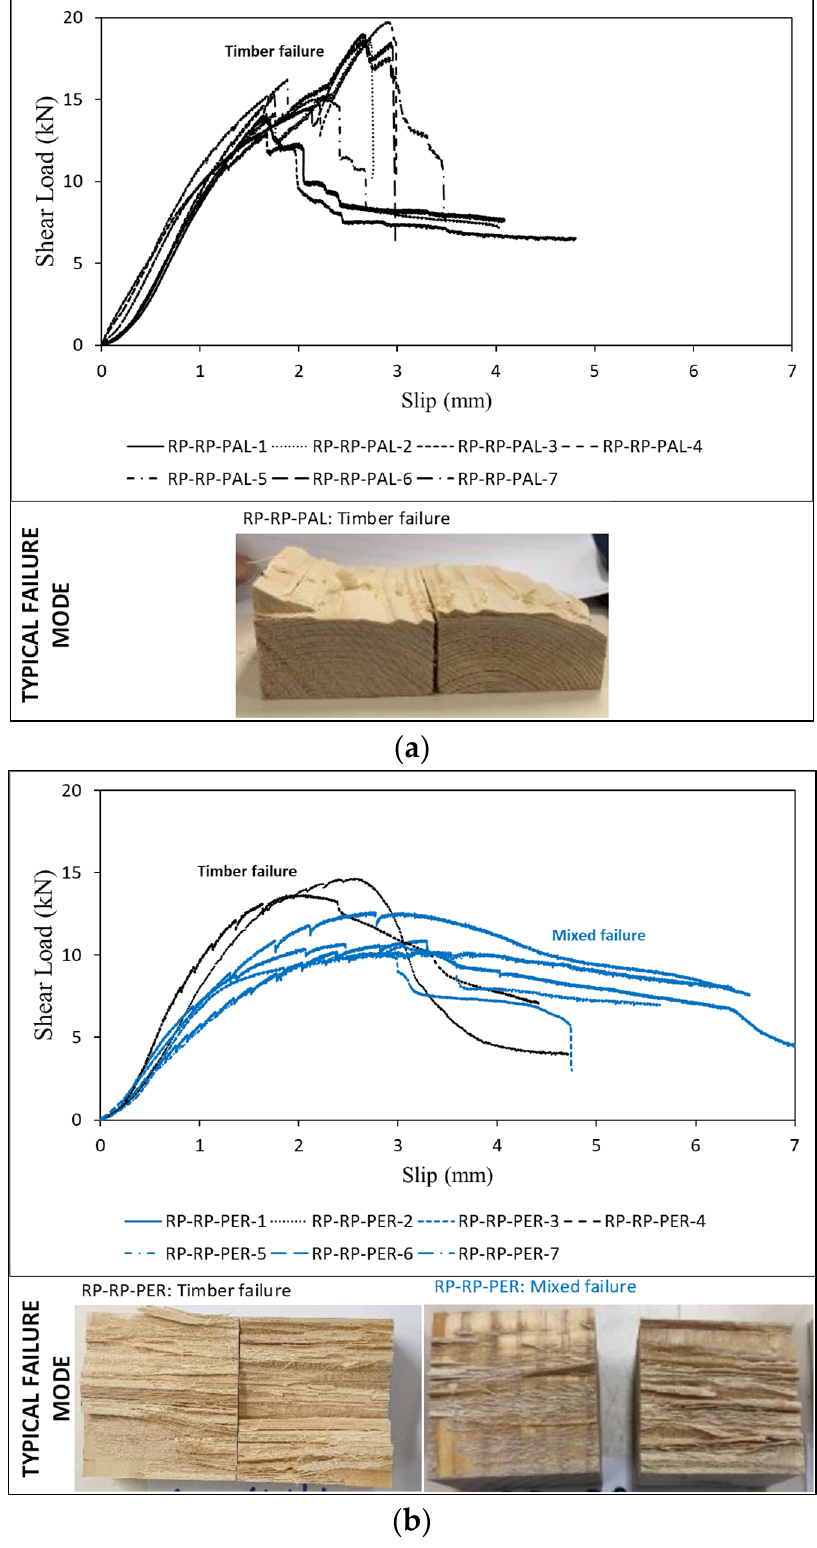
Figure 4. Loading curves and typical modes for RP–RP samples. ( a ) RP–RP–PAL, ( b ) RP–RP–PER. For softwood PER samples, timber failures (two out of seven) and mixed failures ( fi ve